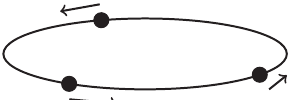
FIG. 1. The semiclassical picture for the effective velocities. There are N particles moving on a circle of circumference L . The only effect of the interaction is the time delays after the scattering events. These delays accumulate and lead to well-defined effective speeds in the long time